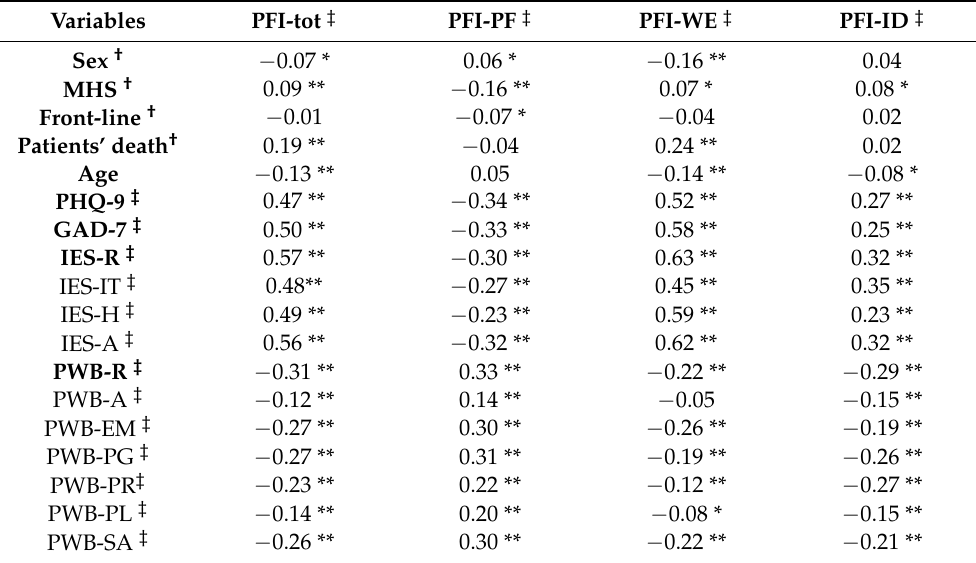
Table 3. Pearson’s correlation between burnout subscales and total score, and study variables.